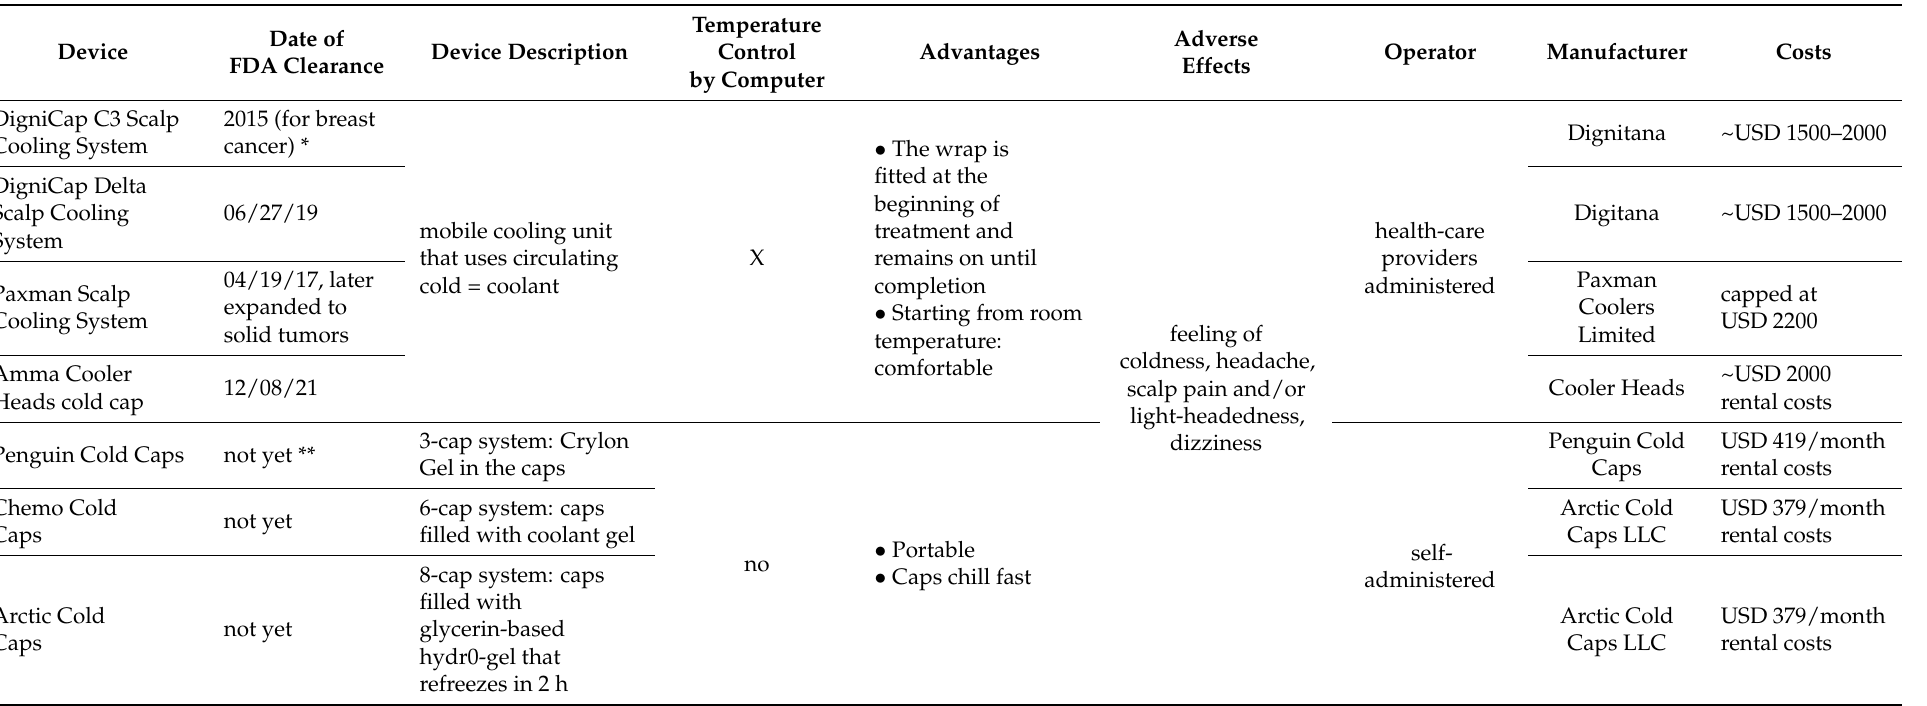
Table 1. Comparison of the different scalp cooling devices used by patients with solid tumors undergoing